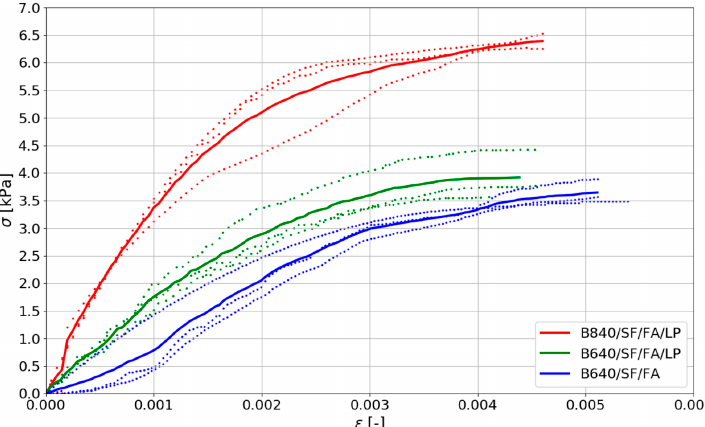
Figure 19. Comparison of compressive strength of columns after 10 h.